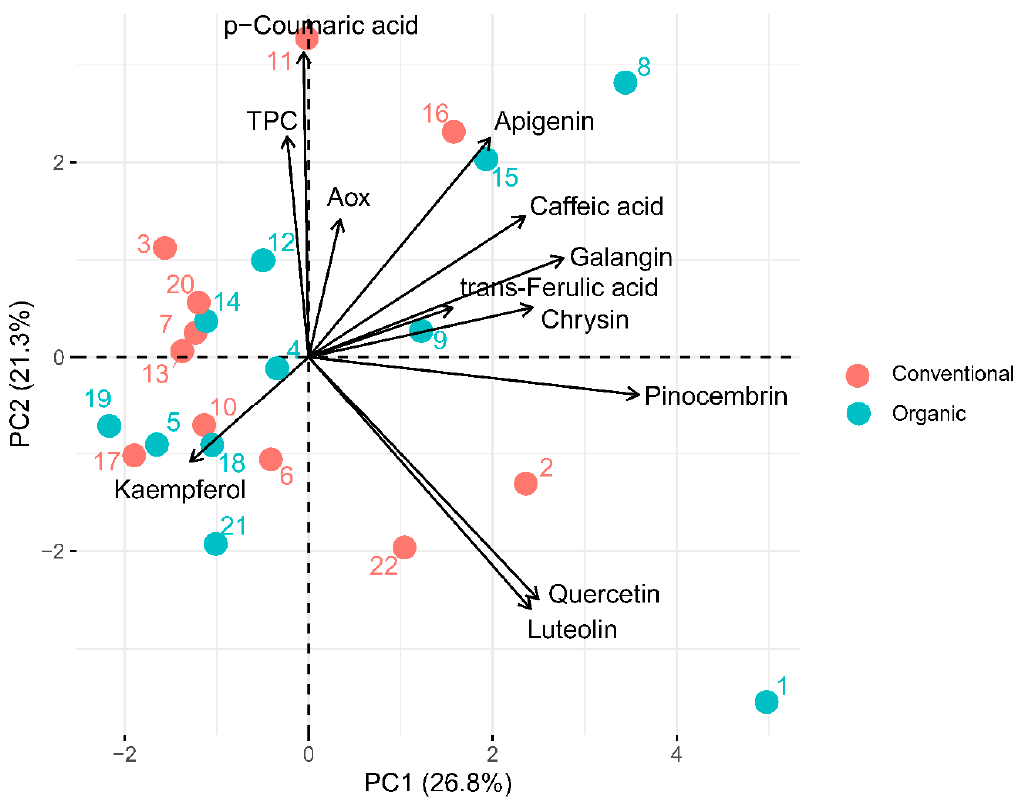
Figure 1. The results of the principal component analysis (PCA) with ● organic and ● conventional honey . On the other hand, the comparison of the average concentrations of the single polyphenols, AOX,